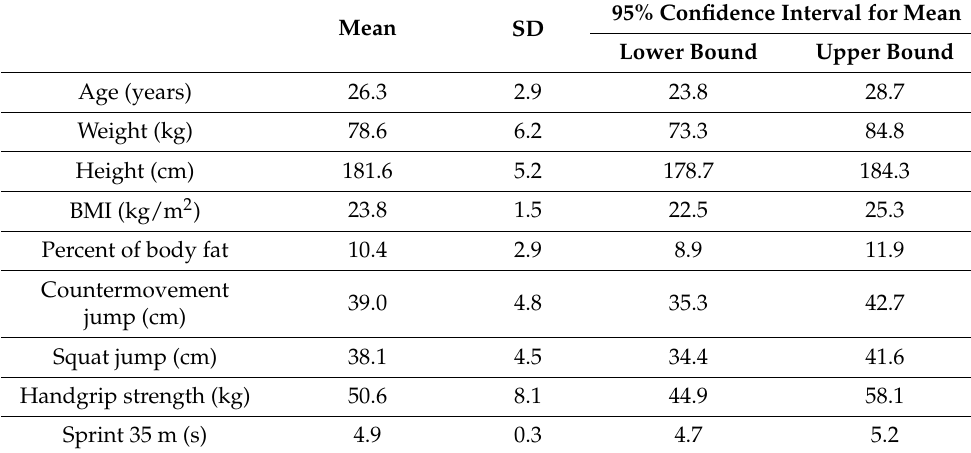
Table 3. Descriptive statistics of age, body composition and physical fitness